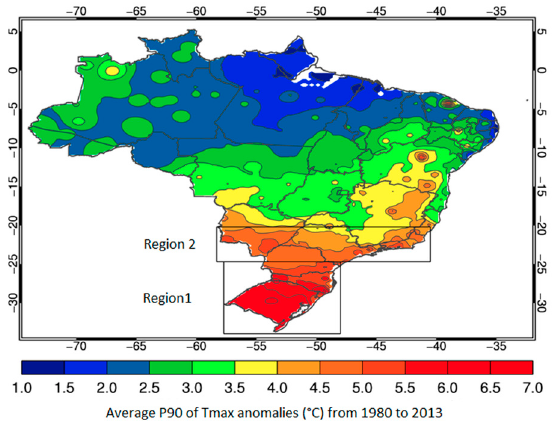
Figure 2. Composition of daily maximum temperature anomalies above the 90% percentile (P90) threshold in Brazil, from 1980 to 2013.